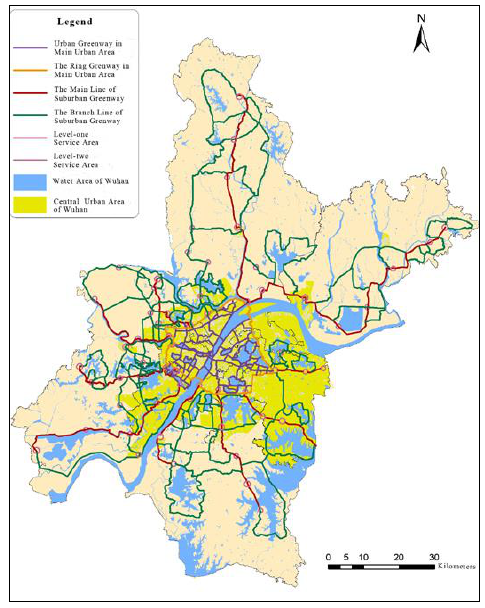
Figure 2. Layout map of Wuhan greenway network.